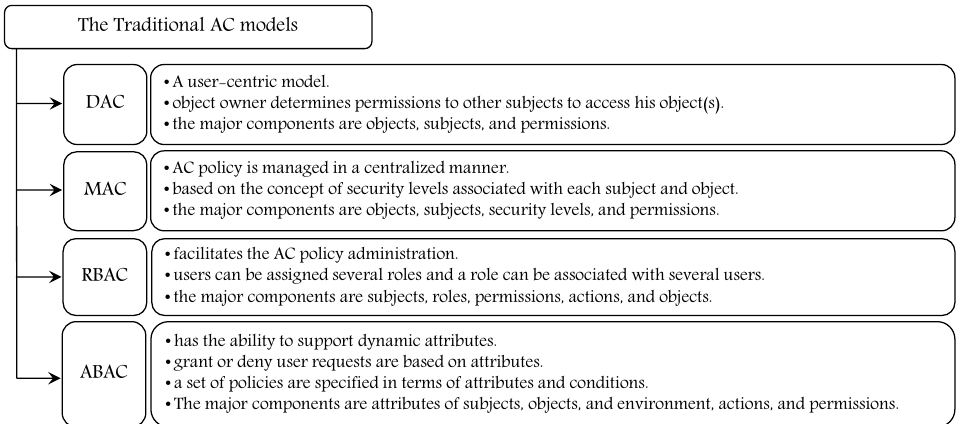
Figure 1. The common AC models.